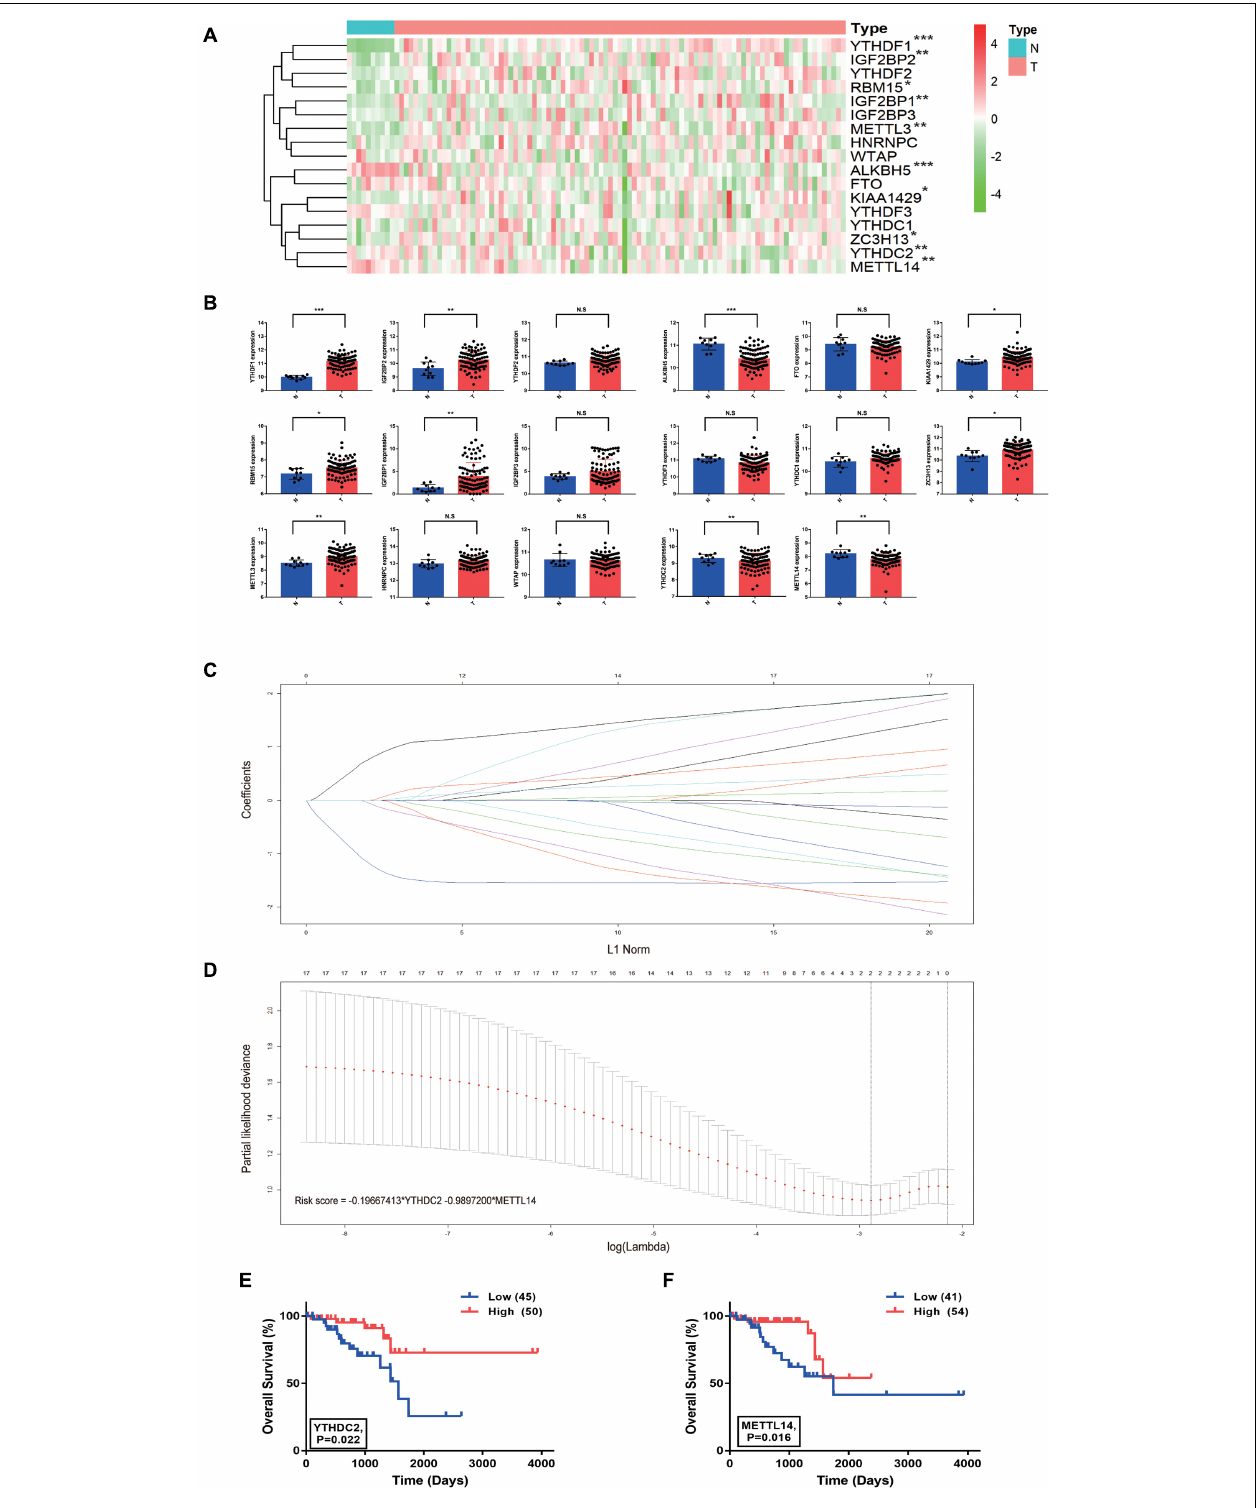
FIGURE 1 | Risk signature with two m 6 A RNA methylation regulator genes in rectal cancer. (A) The heatmap of the expression profiles of the 17 m 6 A RNA methylation regulator genes in the TCGA-READ dataset (N = 10, T = 95). (B) The expression of the 17 m 6 A regulator genes in tumor and normal samples (unpaired T-tests). (C,D) The coefficients estimated by multivariate Cox regression via LASSO are presented. (E) Comparison of overall survival with different YTHDC2 expression. (F) Comparison of overall survival with different METTL14 expression. * P < 0.05, ** P < 0.01, and *** P < 0.001.